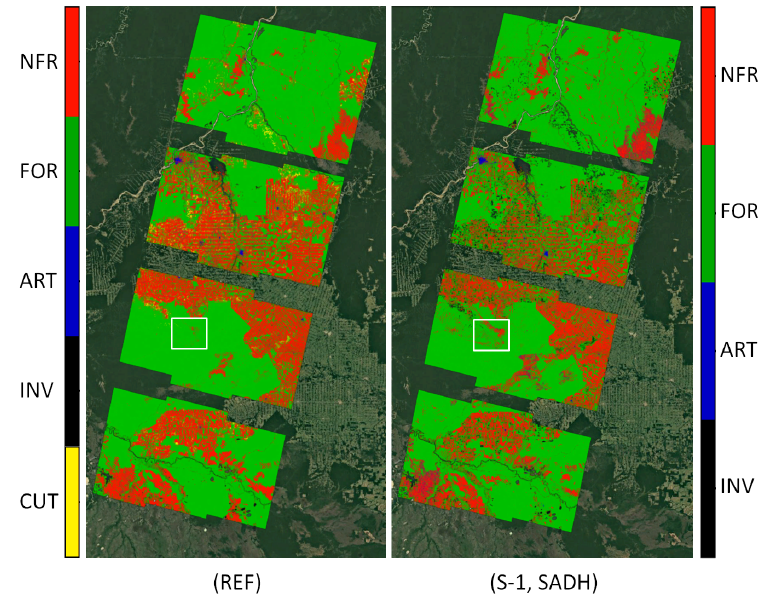
Figure 4. Comparison between the REF reference ( left ), with in yellow the clearcuts (CUT) marked by PRODES between 2017 and 2019, and the final result of the Random Forests algorithm using SADH textures ( right ). The white square identifies a region of interest in which the maps are clearly different. Such an area corresponds to the Pacaás Novos National Park and is separately analyzed in Figure